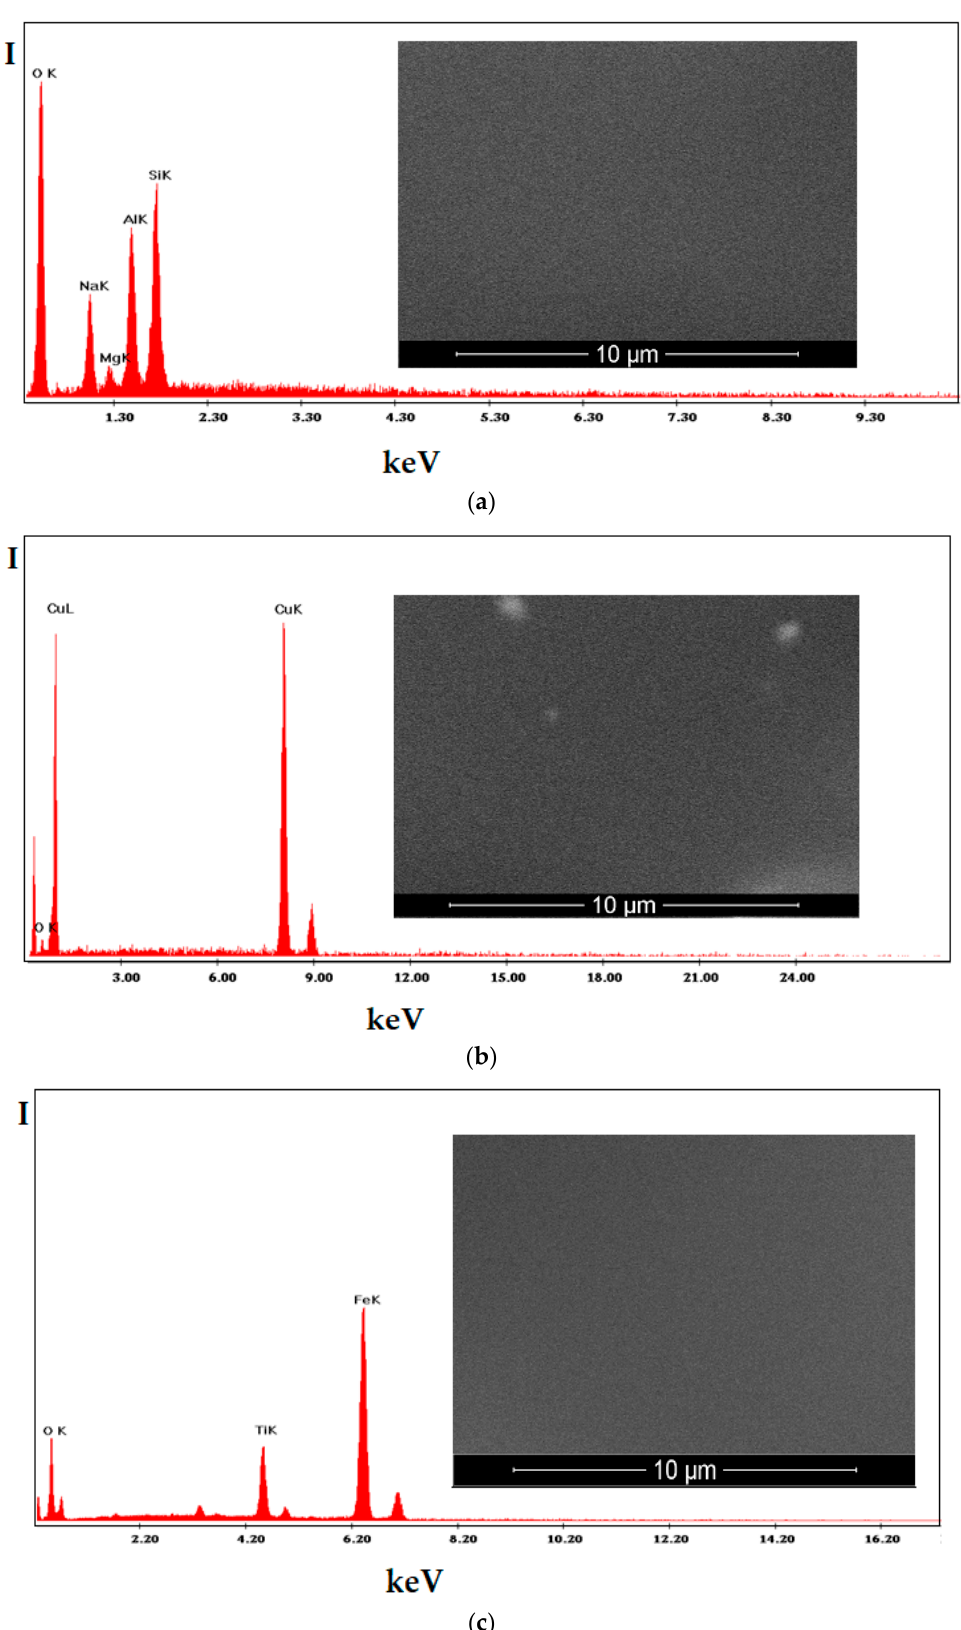
Figure 8. Morphology and composition of the surfaces of the spheres from: ( a ) glass; ( b ) copper; ( c ) titanium steel; obtained by scanning electron microscopy (SEM) and energy dispersive spectroscopy analysis (EDX).